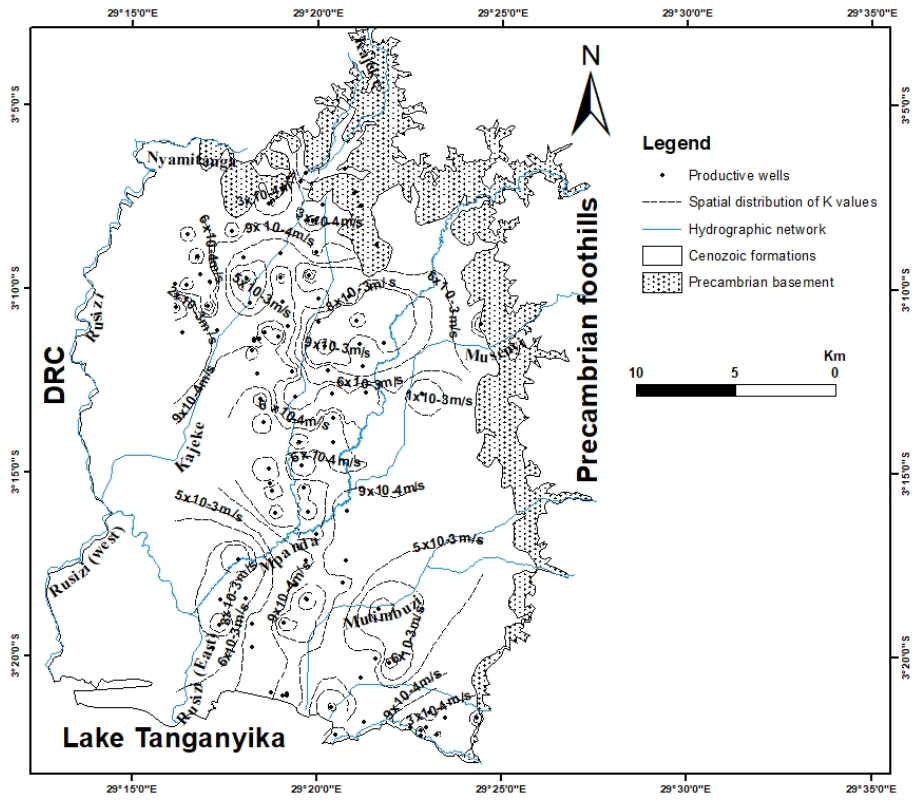
Figure 4. Map showing the location of drilling and spatial distribution of hydraulic conductivities values in the lower Rusizi plain [3].